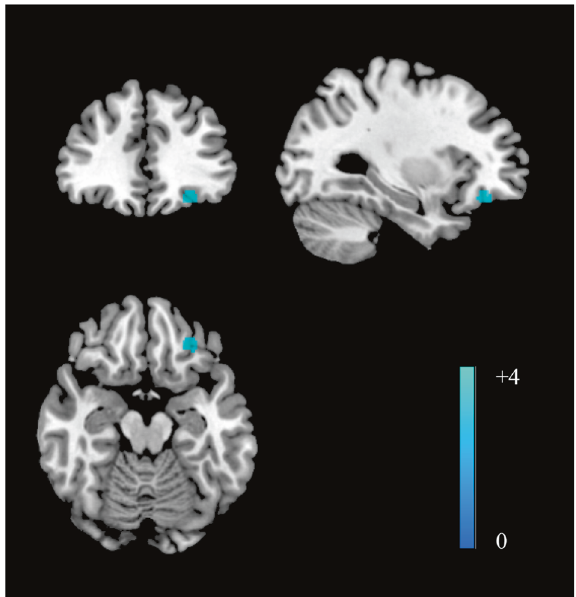
Fig. 1 Group differences of meta-analysis. Compared with healthy controls, patients with recurrent MDD exhibited decreased NAc functional connectivity in the left ventromedial prefrontal